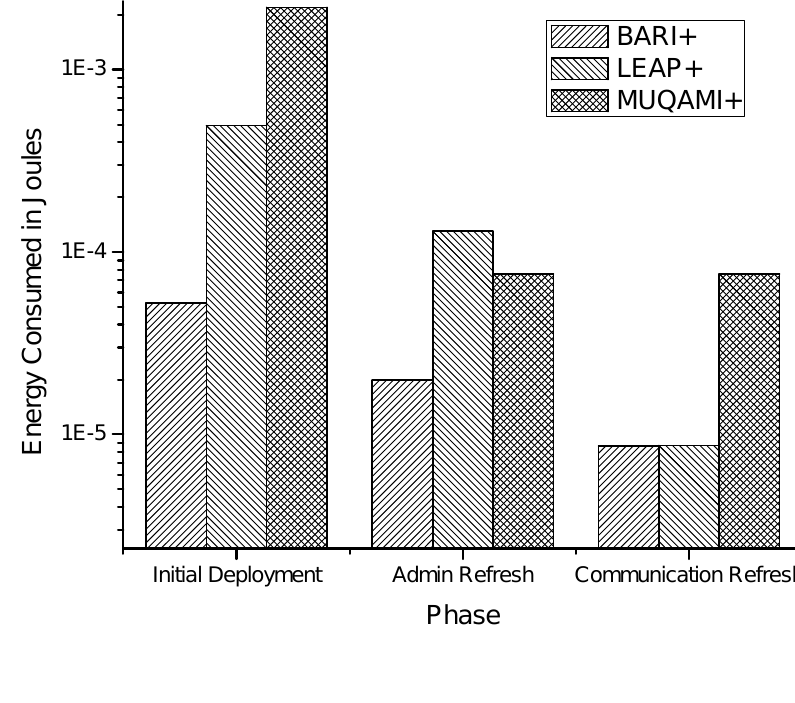
Figure 5. Comparison of average energy consumed by a personal server in different phases of each scheme.